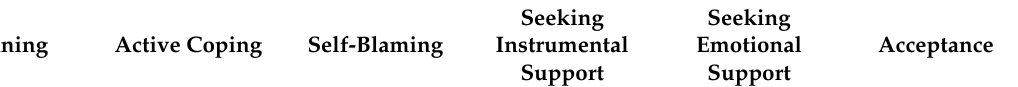
Table A1. Levels of statistical significance for post hoc pairwise comparisons of stress-coping strate- gies chosen in population presenting TMD